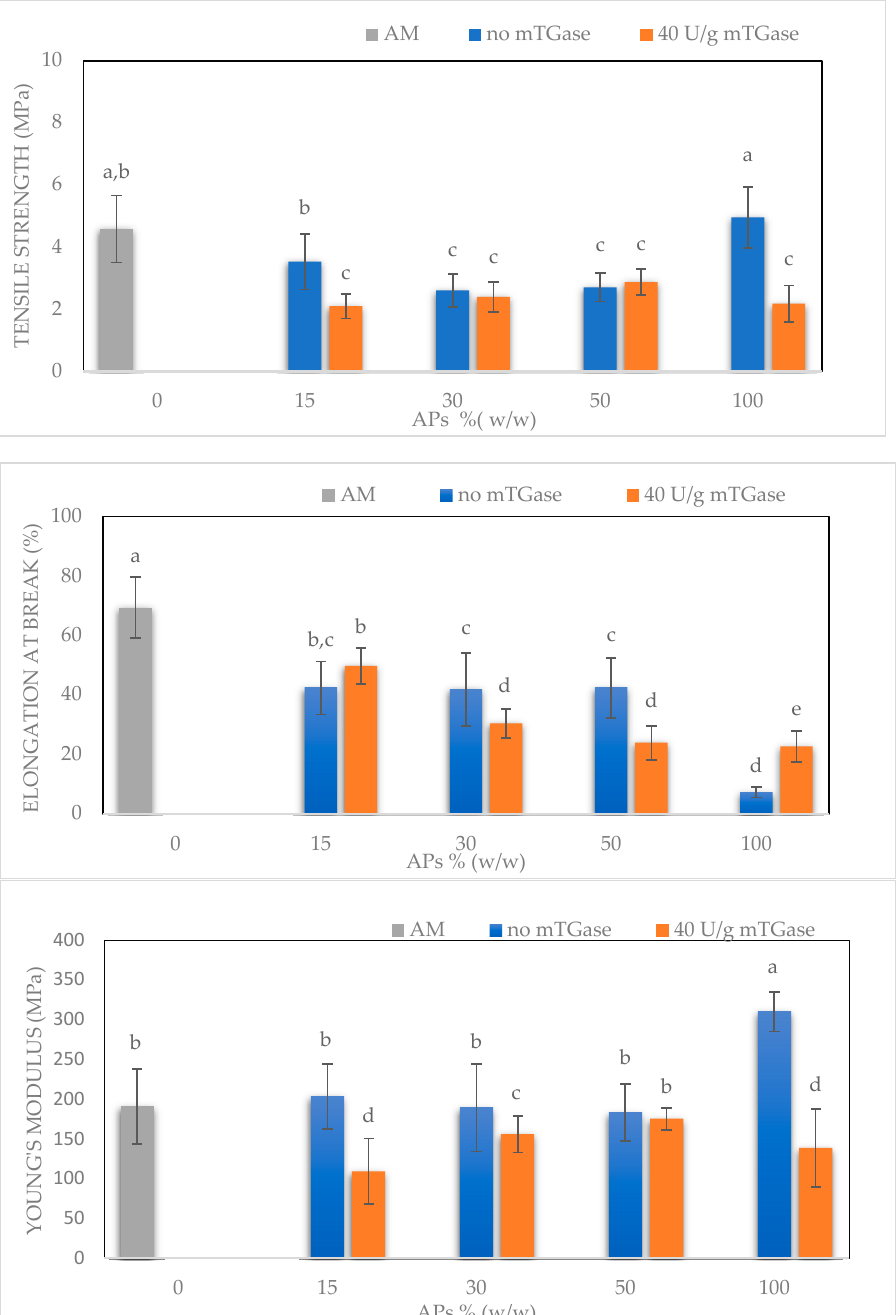
Figure 5. Mechanical properties of films containing 50% ( w/w ) glycerol, prepared at different ratios of APs-AM and treated or not by mTGase (40 U/g). Different small letters (a–d) indicate significant differences among the values reported in each bar ( p < 0.05). For each sample six specimens were evaluated.